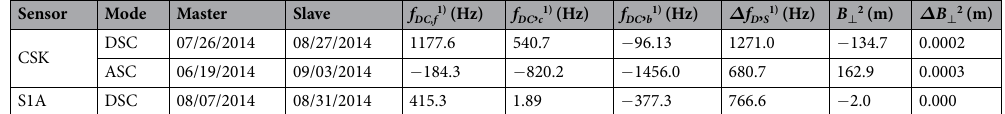
Table 1. Characteristics of interferometric pairs used in this study. 1) f DC , f , f DC , c , and f DC , b denote the forward, average, and backward Doppler Centroids, respectively, and Δ f D , S is the sub-aperture processing bandwidth. 2) B ⊥ is the perpendicular baseline of the forward-looking interferogram and Δ B ⊥ is the perpendicular baseline